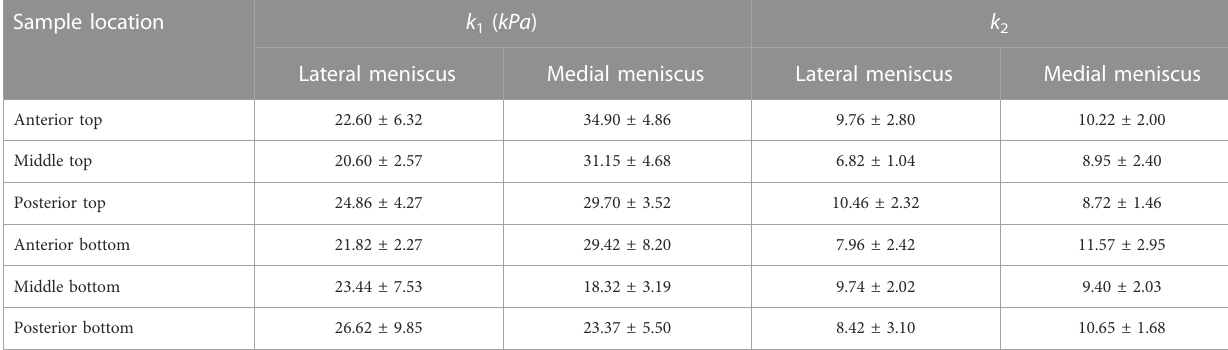
TABLE 3 The average values of k 1 and k 2 for samples from different locations of the lateral and medial menisci. Sample